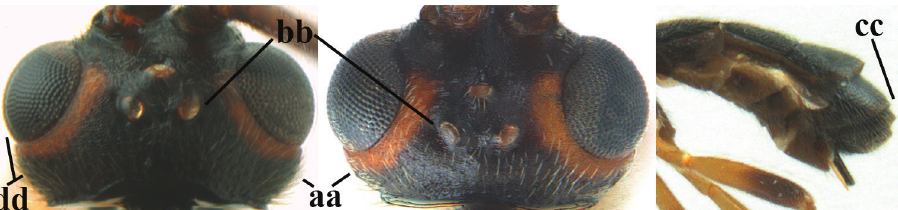
25 Face yellowish brown (a); ocelli smaller, POL 0.8 × as wide as diameter of posterior ocellus (b); pale area of second tergite wide (c); mesoscutum with pair of yellowish brown stripes (d; but in males sometimes only vaguely indi- cated); medio-posterior depression of metanotum wide (e); palpi pale yellow- ish (f); vein cu-a of fore wing subvertical (g); face mainly transversely rugose (h) ...................................................................... A. cantherius (Lyle, 1919)